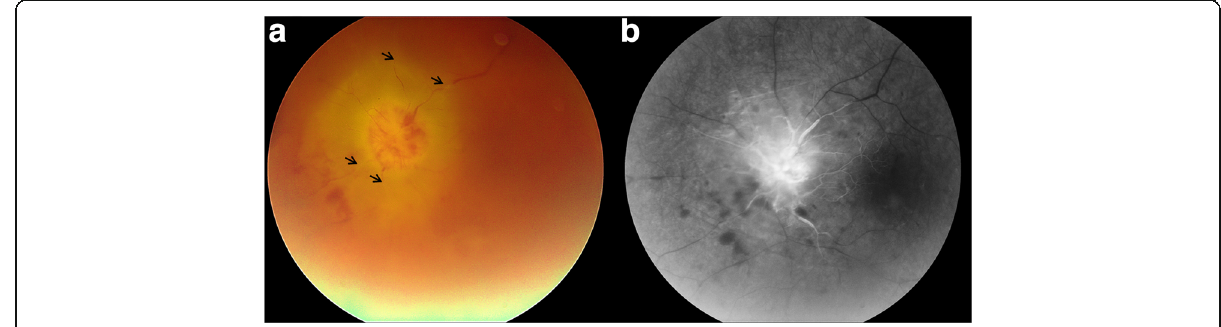
Fig. 1 a Color photograph of the left disc and macula shows pale disc edema, marked irregularity of the retinal vasculature (arrows) and hemorrhages inferior and nasal to the optic disc. b The arteriovenous-phase fluorescein angiogram of the left disc and macula shows an optic disc staining, as well as extensive non-perfusion of the retinal vasculature and venous congestion. Of note, the blot hemorrhages inferior to the optic disc cause irregular hypofluorescent